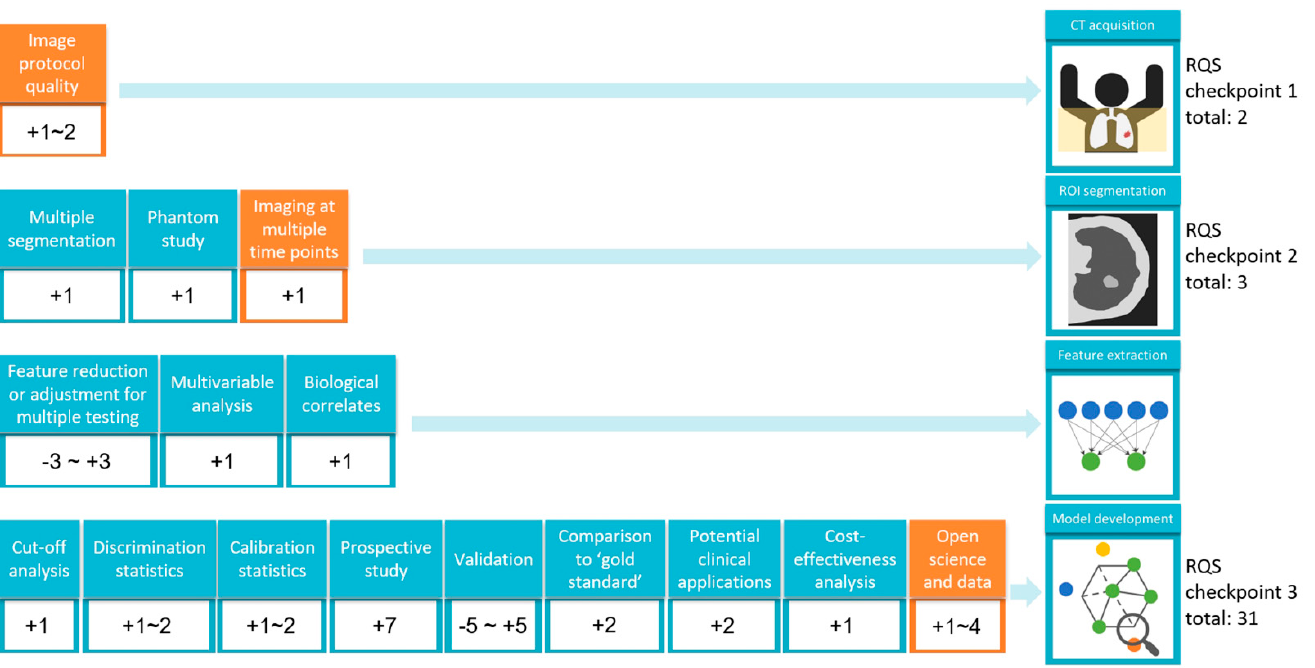
Figure 2. Flowchart describing the workflow process of radiomic texture analysis and modeling development for early lung cancer diagnosis with the application of the radiomics quality score (RQS), which was used to assesses the characteristics and the quality of the radiomics studies and report guidelines. Detailed RQS scores with 16 domains were recorded (domain 1: image protocol